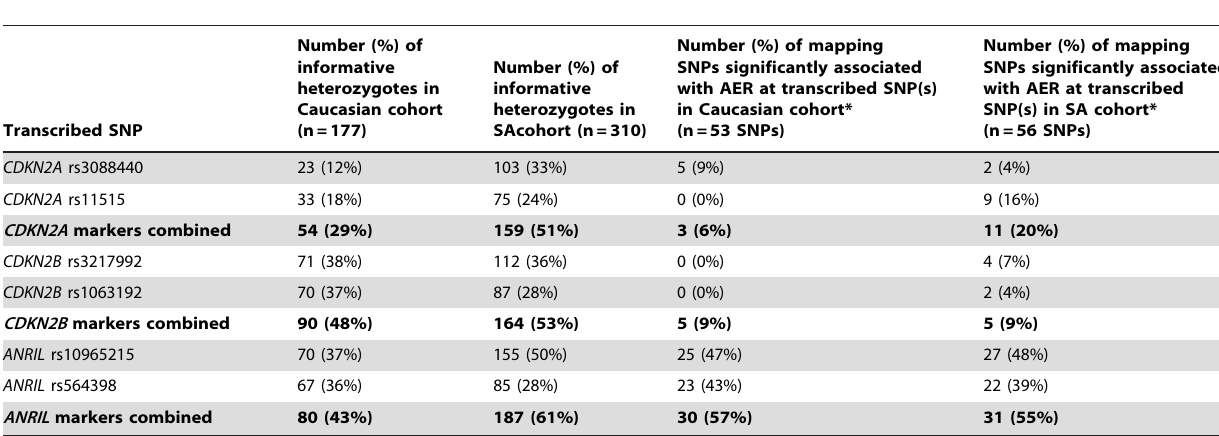
Table 1. Increase in number of informative heterozygotes and associated SNPs using two transcribed SNPs per gene.